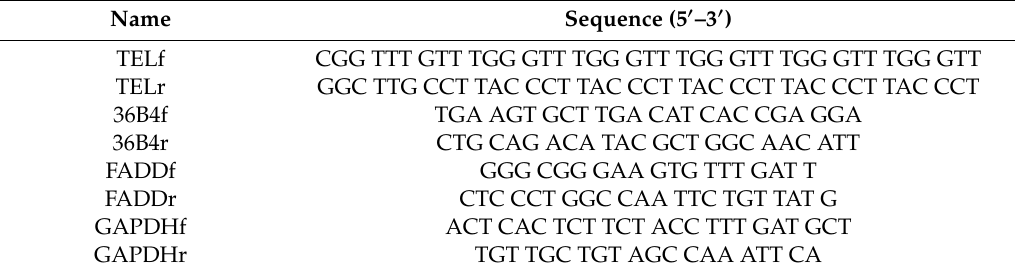
Table 2. Oligonucleotide primer sequences used for telomere length measurement and